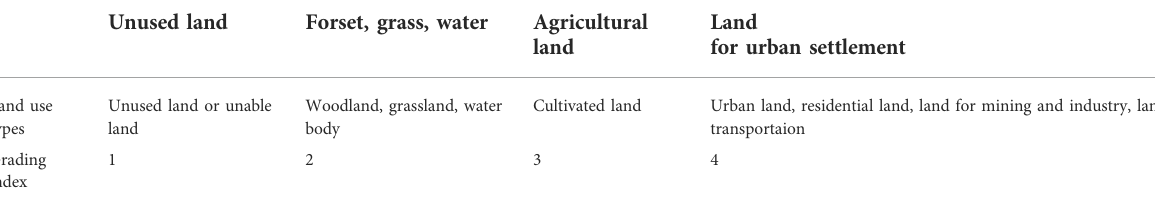
TABLE 1 Land use degree classi fi cation